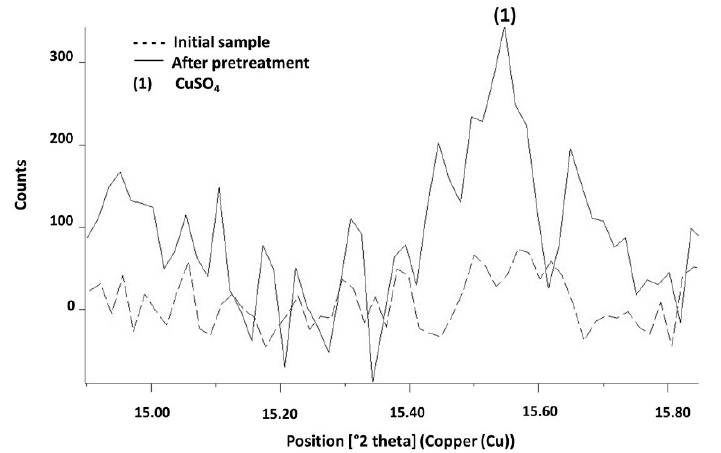
Figure 7. NaFe 3 (SO 4 ) 2 (OH) 6 , a product of the pretreatment of copper sulphide ores with 15 kg/t of H 2 SO 4 , 25 kg/t of NaCl, and 15 days of curing at room temperature as identified by X-ray diffraction. In ( a , b ), the new presence of NaFe 3 (SO 4 ) 2 (OH) 6 was identified as (1), compared to the initial diffractogram of the sample.